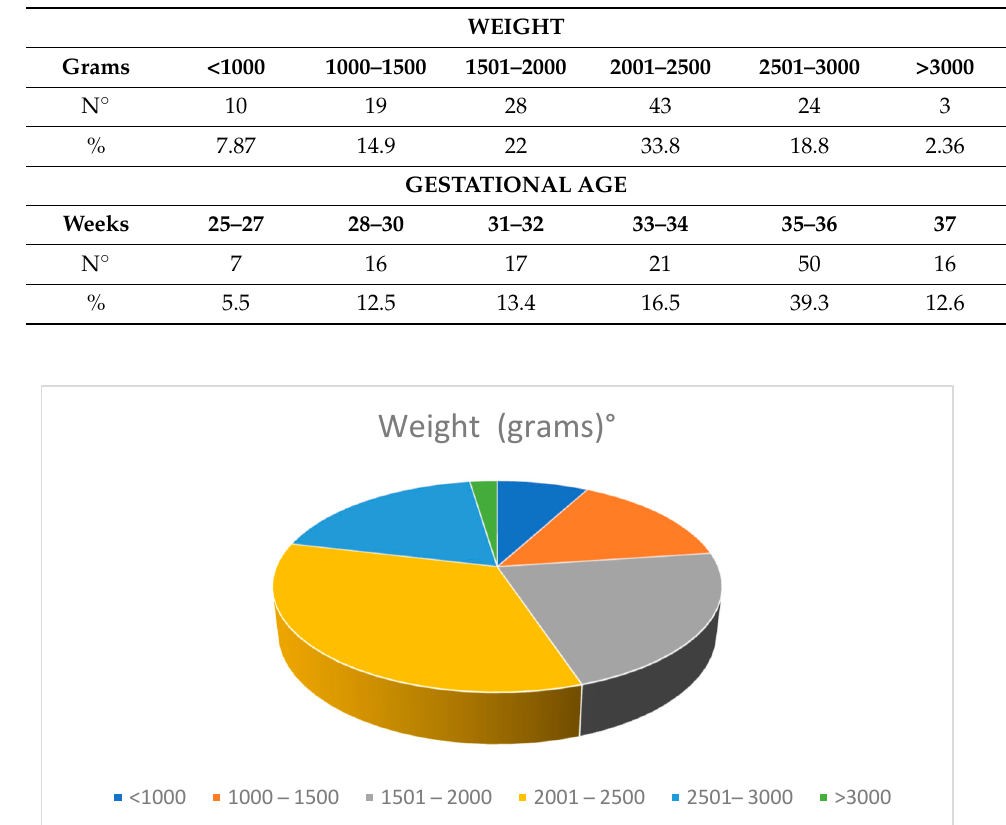
Figure 4: Population data. Distribution by weight. The gestational age for the multiples ranged between 25 and 37 weeks. 111 of 127 (87%) were premature infants: 40 twins (31.4%) were born at ≤ 32 weeks of gestational age and 16 (12.5%) at 37 weeks. (Table 5, Figure 5)